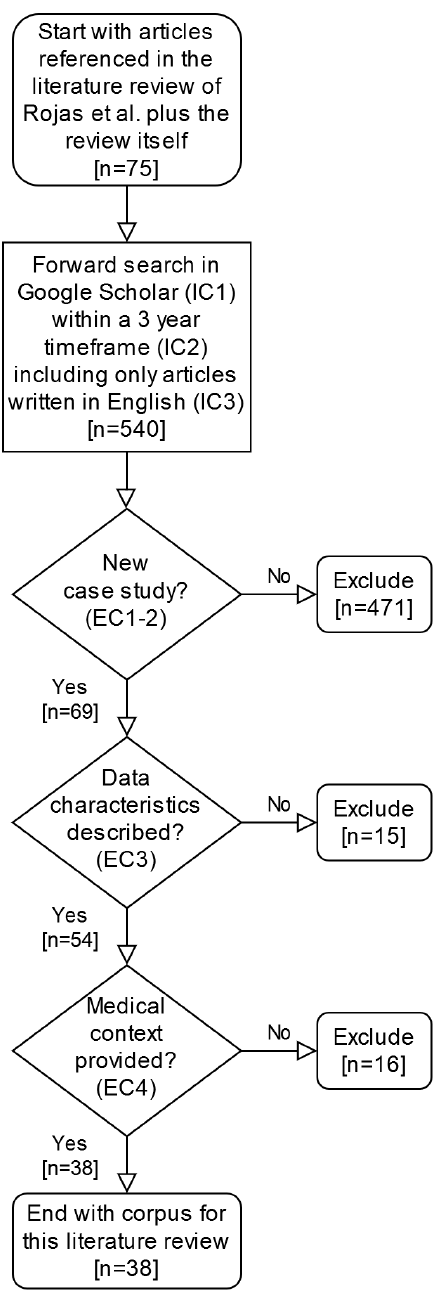
Figure 1. Flowchart on the case study selection